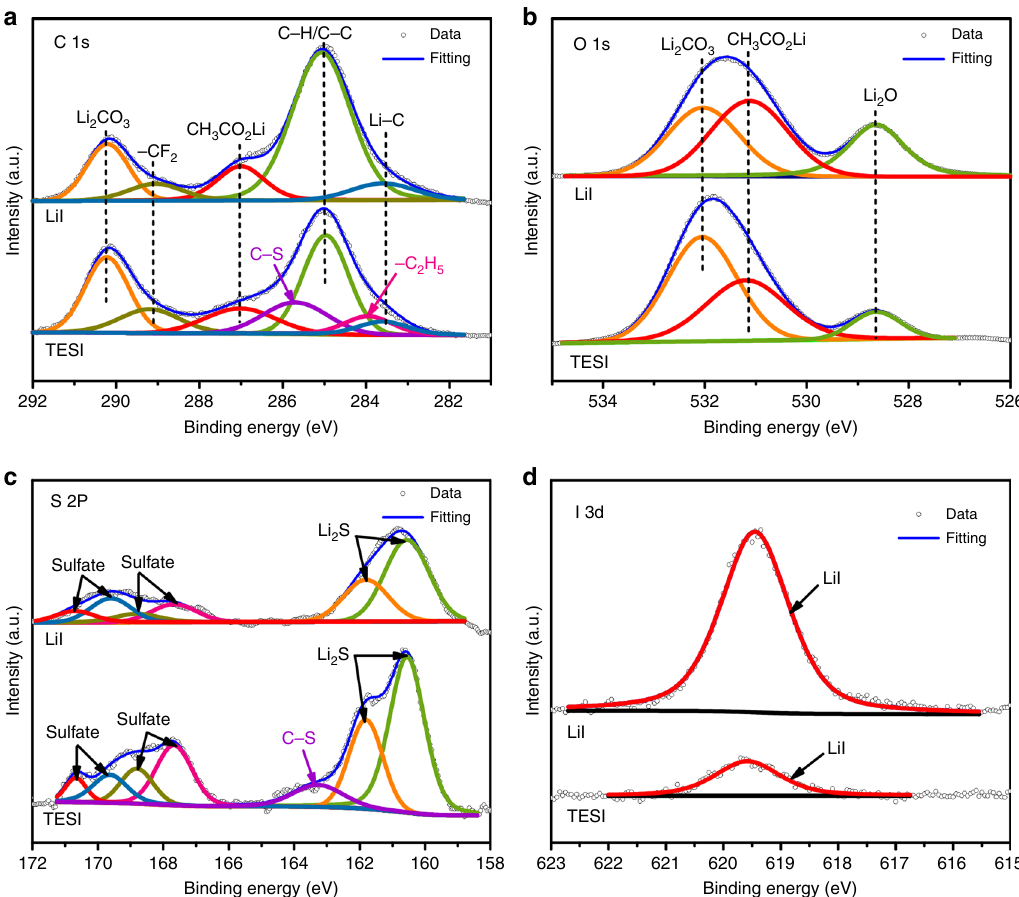
Fig. 5 XPS spectra on the surface of Li anodes. Two samples from the Li – O 2 cells with 50 mM TESI after 60 cycles and 50 mM LiI additives after 30 cycles were measured. a C 1s spectra. b O 1s spectra. c S 2p spectra. d I 3d